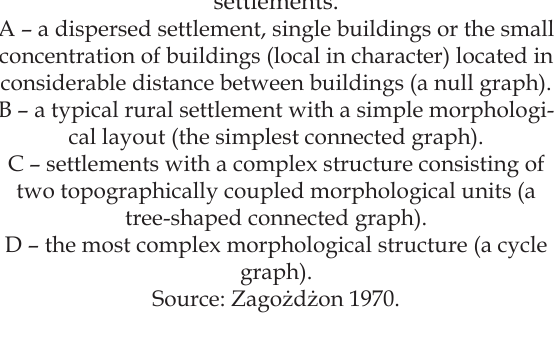
Fig. 1. Graphs identifying morphological layouts of settlements.